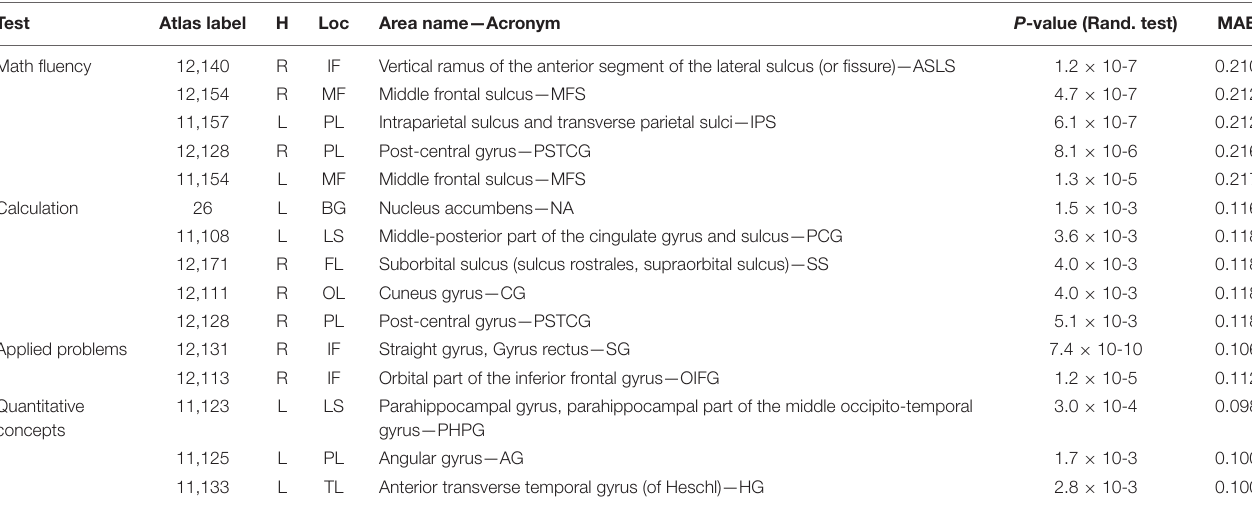
TABLE 3 | Predictive areas of math performance in the four tests of the WJ-III battery.